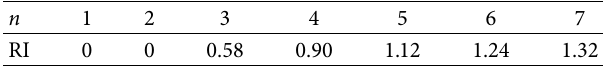
Table 7: RCI values of different order sets of n